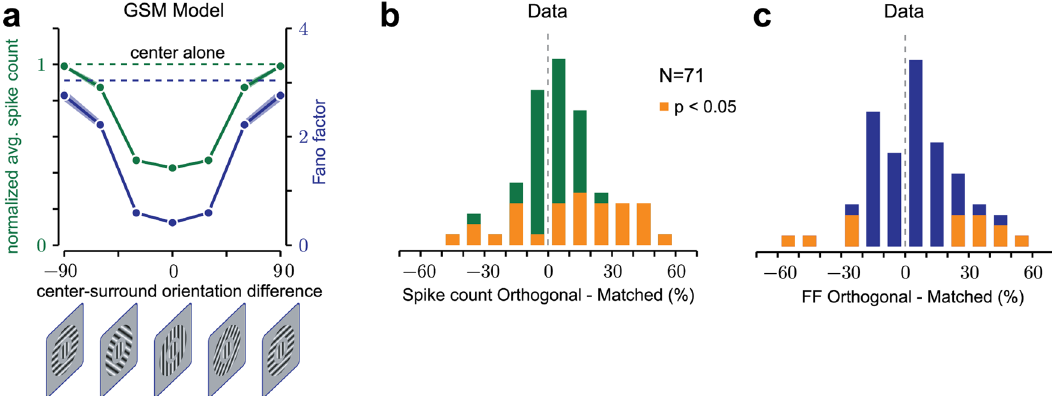
Fig. 3 Surround reduction of variability is orientation tuned. a Surround-orientation tuning of the mean spike count (green circles) and FF (blue circles), relative to the center stimulus alone (dashed lines) in the GSM model. Error bars: 68% c.i. computed by bootstrapping. Scaling factor (Methods Eq. 4) c = 40 ( b , c ) Percent change in the mean spike count ( b ) and Fano factor ( c ) from orthogonal to matched surround orientation, in V1 of two awake fi xating macaques. Yellow bars denote neurons with a signi fi cant change across conditions. The difference is considered signi fi cant when the 68% c.i. ’ s of the two conditions (computed by bootstrapping) do not